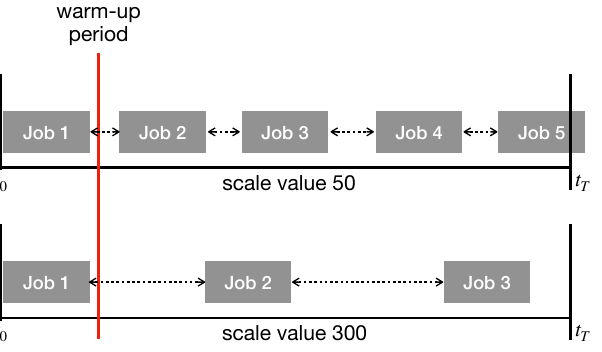
Figure 1. A timeline of multiple jobs injected into the job queue at different scales. A smaller scale value means a higher injecting rate. Fast job injections make scheduling tasks more difficult, especially when there are continuously overlapping jobs, which add more complexity. The timeline starts at t 0 and finishes at t T , where T is a final time step. Note that in the top diagram, job 5 is discarded as the simulation terminates, because the performance only takes account of completed